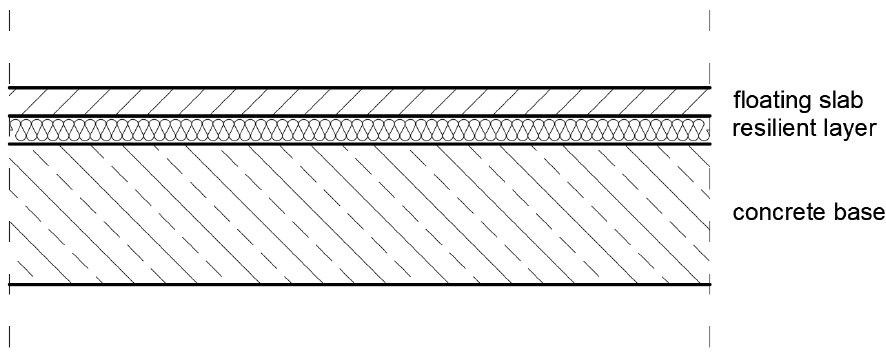
Figure 13. An example of floating floor system screeds made of sand/cement or calcium sulfate with rebound polyurethane foam as a resilient layer (own elaboration).